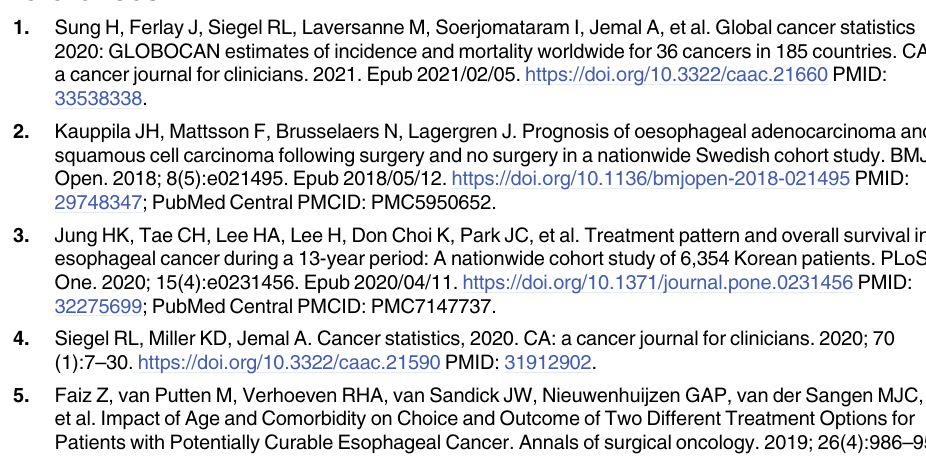
S3 Fig. Comparison of receiver operating characteristic (ROC) curves for prediction of 30-day mortality in cirrhotic patients by Bilirubin, INR and platelet count. Bilirubin pro- vides an excellent and INR an outstanding diagnostic capacity, whereas the platelet count fails in prediction of 30-day mortality. p-values in bold indicate statistical significance between cohorts. AUC—area under the curve, CI—confidence interval, INR—international normalized ratio. S4 Fig. Cumulative Survival curves after esophagectomy of cirrhotic (LCP) and non-cir- rhotic patients (NLCP). 1-, 3- and 5-year survival were 79.1%, 50.0% and 36.4% in the NLCP cohort and 60.0%, 7.1% and 20.0% in the LCP group. In-hospital deaths and 19.2% of NLCP were lost to follow-up and excluded from analysis. p-values in bold indicate statistical signifi- cance between